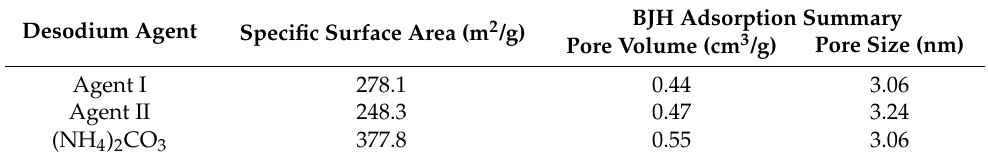
Figure 4. XRD pattern ( A ) and nitrogen adsorption–desorption isotherms ( B ) of products synthesized with different desodium agents. Table 6. Effect of desodium agent on physical properties of the nanosized